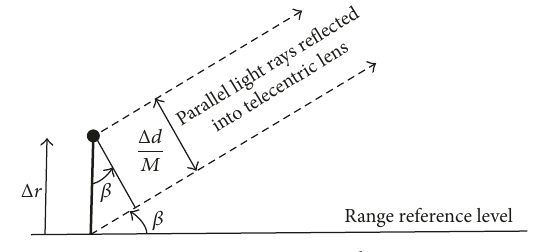
Figure 4: Linear triangulation.